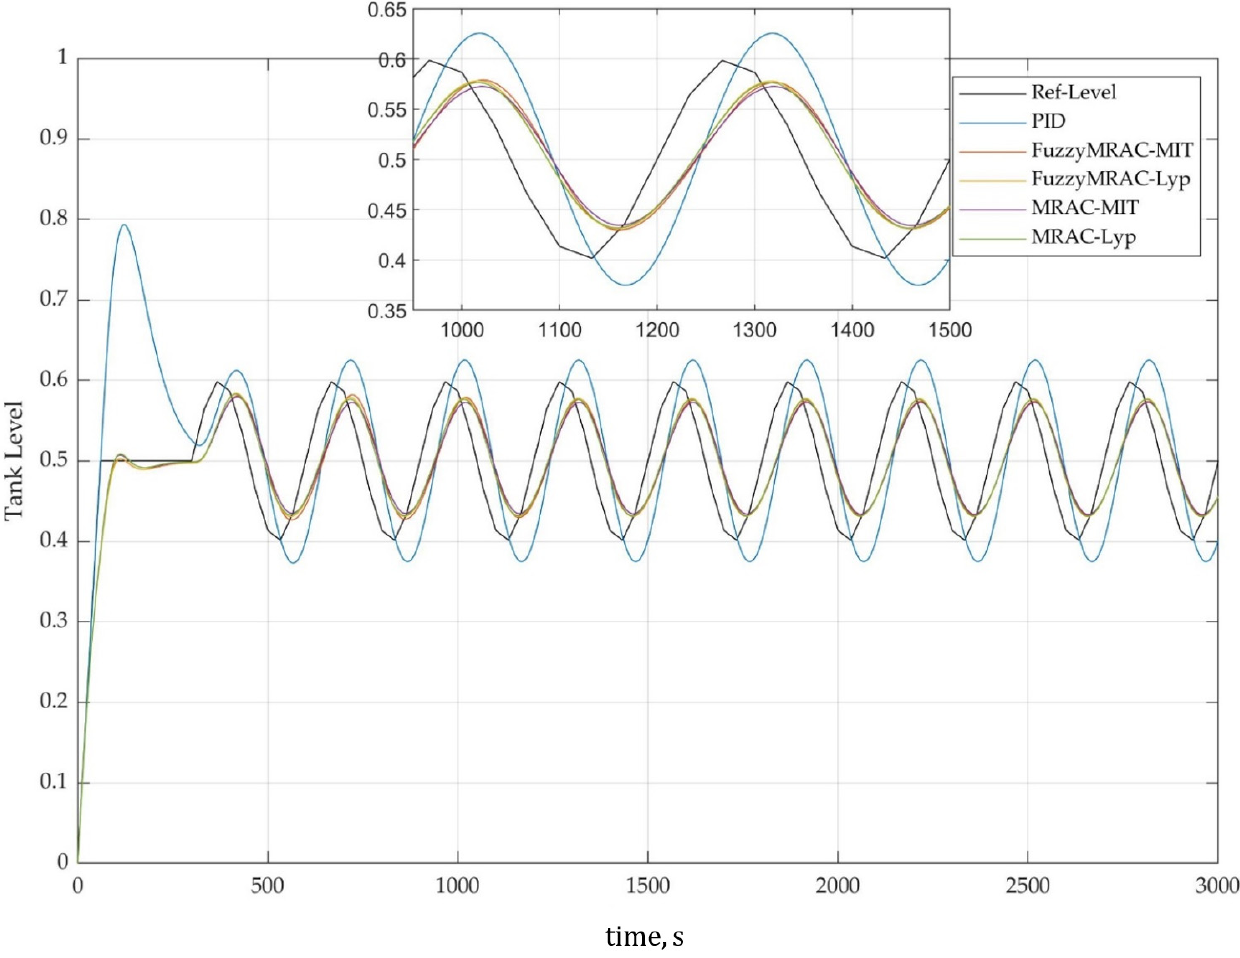
Figure 14. Tank level control using fuzzy MRAC, MRAC and PID with variable reference change.